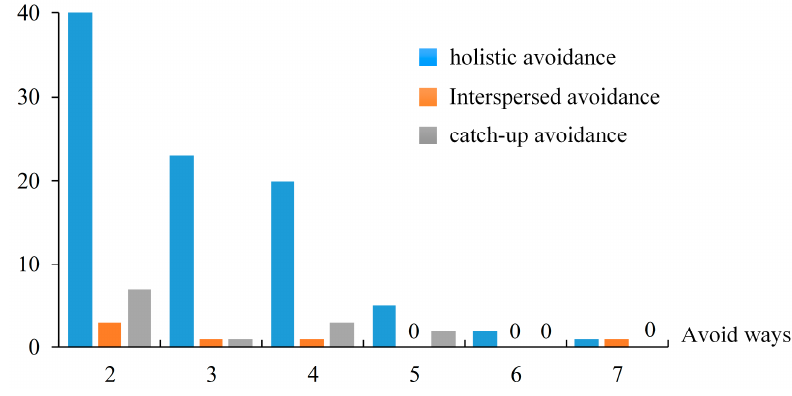
Figure 4. Number of three avoiding ways of each size group.